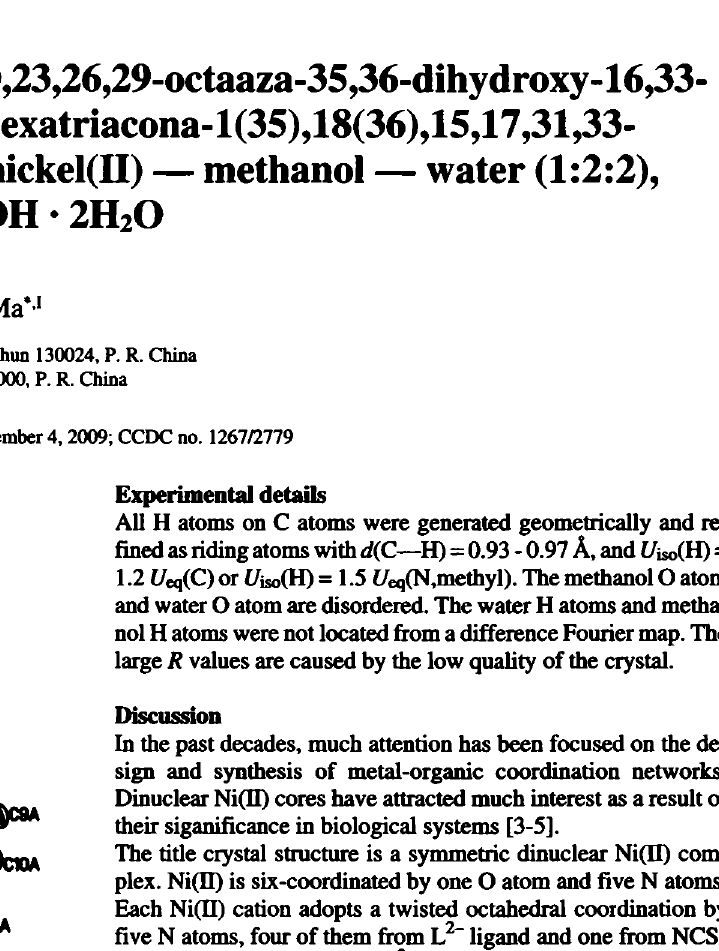
Table 1. Data collection and handling.